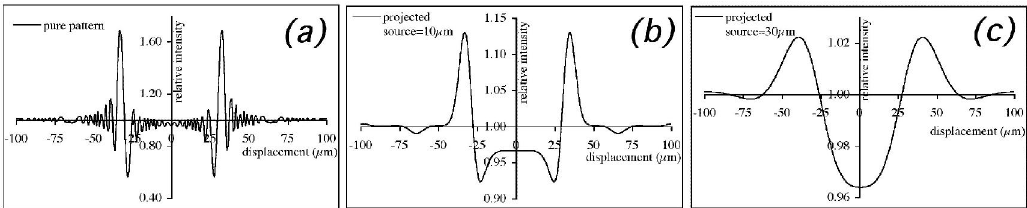
Figure 3. The effect of an increasing projected source size s pattern. The pattern in ( a ) was created by numerically solving the Fresnel/Kirchoff diffraction integral [3] for a 50 µm thick polyethylene wire, and convolved with Gaussian distributions with a width of 10 and 30 µm to obtain plots ( b ) and ( c ),